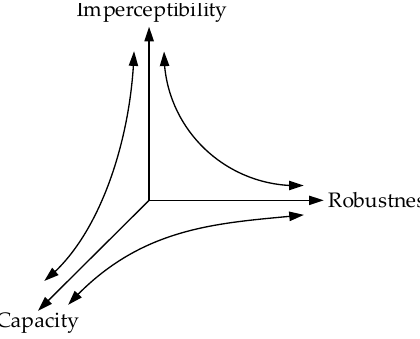
Figure 7. Relationship among watermark capacity, imperceptibility, and robustness.